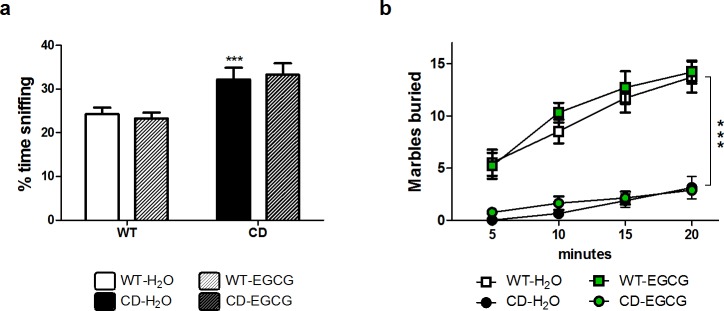
EGCG does not influence sociability or anxiety-related behavior in CD mice.(a) In a direct social test, CD mice fed with green tea behaved in the same way that water fed CD mice towards an intruder mice. A two-way ANOVA indicated a significant main effect of genotype (F1,37 = 19.86, p<0.0001), without effect of treatment (F1,37 = 0.00044, p = 0.9834). n = 7–15 per group. White, WT; Black, CD. Plain, water; Striped, EGCG. Data are presented as the mean ± SEM. (b) Anxiety-like behavior was evaluated in the marble-burying test. A three-way ANOVA revealed no interaction between genotype, treatment and time (F3,128 = 1.380, p = 0.252), with a significant main effect of genotype (F1,128 = 306.684, p<0.0001) and time (F3,128 = 17.170, p<0.0001) but no effect of treatment (F1,128 = 0.182, p = 0.670). n = 8–10 per group. Squares, WT; Circles, CD. White and black, water; Green, EGCG fed mice. p values are shown with asterisks (genotype effect) indicating values that are significantly different in a two-way ANOVA with Bonferroni post hoc test (***p<0.001).